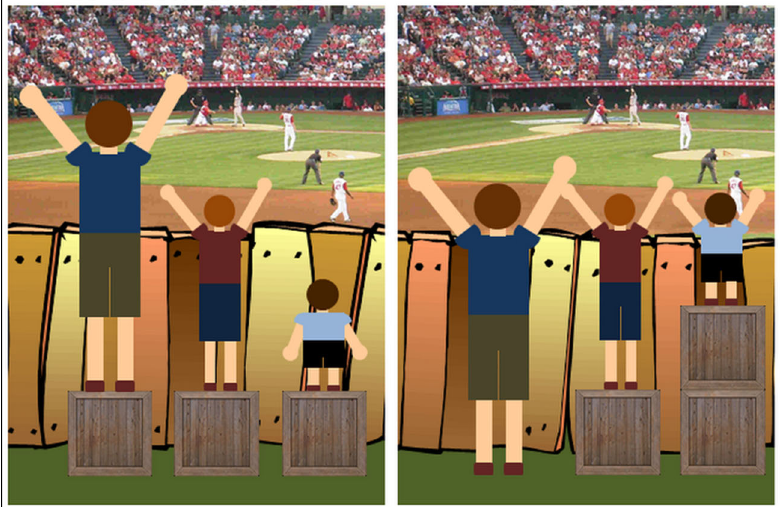
Figure 3. The “Equality vs. Equity” Meme First posted by Craig Froehle in 2012, this was later adapted by others to illustrate equality vs. equity and, in some versions, “liberation” with the removal of the fence or “reality” with boxes stacked to favor the tallest